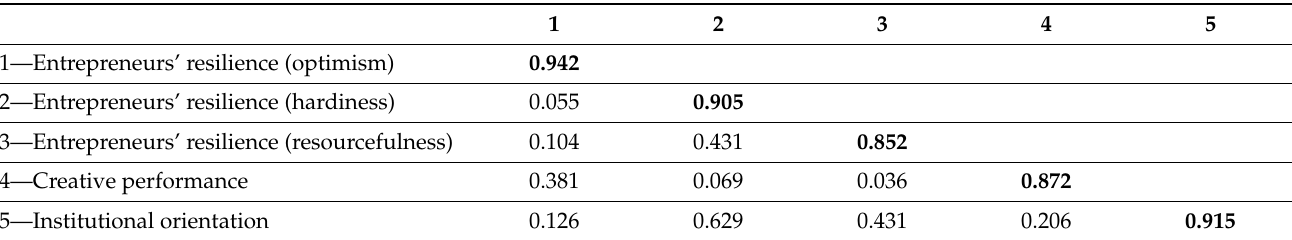
Table 4. Discriminant validity based on Fornell–Larcker criterion Table 3. Results of first-order CFA M and standard deviation.